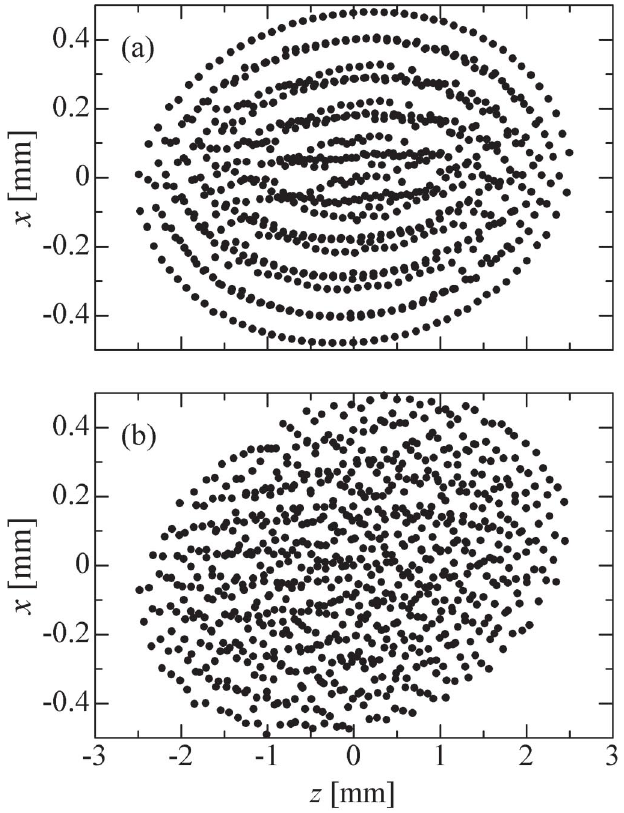
FIG. 8. Top views of ultralow-emittance beams in S-LSR. The fundamental lattice parameters are the same as those assumed in the previous figures except that we have now switched on rf fields to bunch the beam. The number of 24 Mg (cid:4) ions in a bunch is 800 in these simulations. Case (a) corresponds to the situation where we have turned on six rf cavities symmetrically set around the ring. The amplitude of the rf voltage has been chosen to be 48.8 V. In case (b), five of them have been switched off. In order to keep the synchrotron tune unchanged, the rf amplitude has been increased to 272 V.